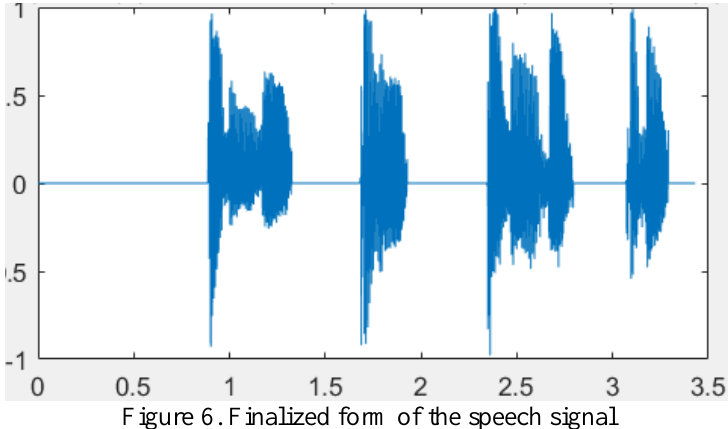
Figure 6. Finalized form of the speech